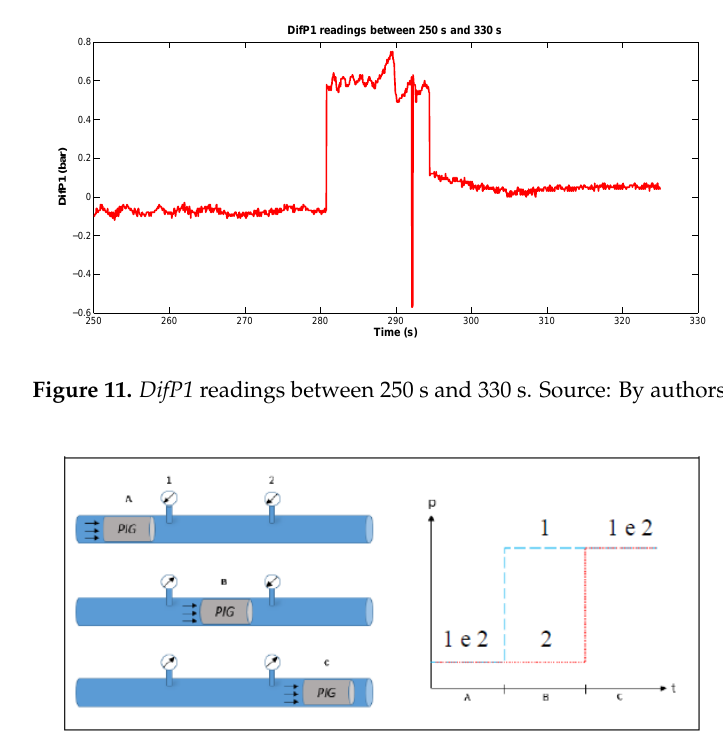
Figure 12. Effect of PIG on the readings of two consecutive pressure sensors. Source: From Freitas